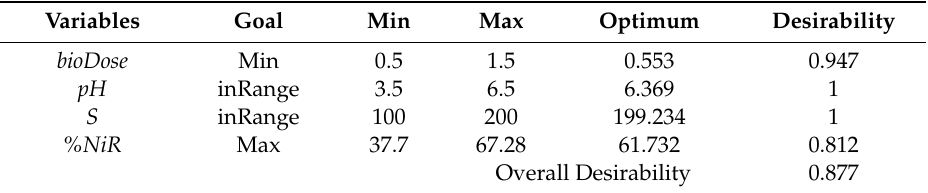
Table 8. The first biosorption optimization scenario: minimizing the biosorbent dosage consumption to obtain the highest Ni(II) removal e ffi ciency.